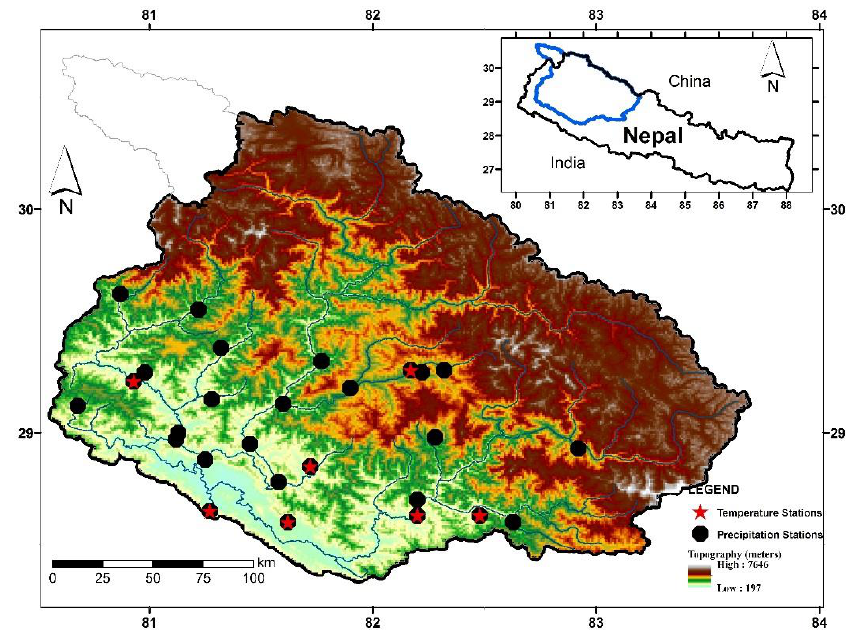
Figure 1. Karnali River Basin in western Nepal showing the precipitation and temperature measuring stations used in the study.